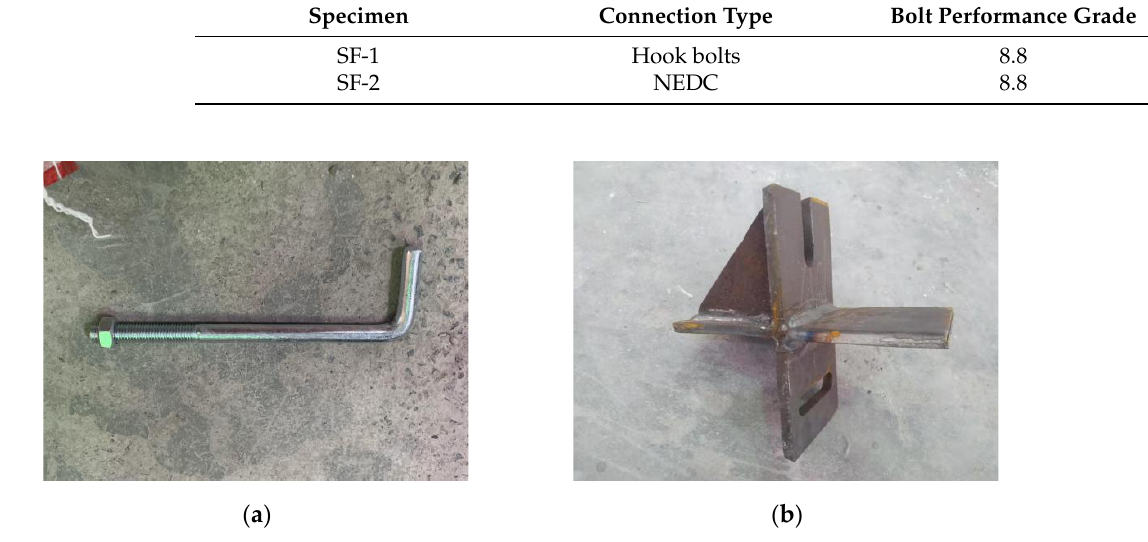
Figure 6. Pictures of the connectors used: ( a ) hook bolts; ( b ) NEDC.